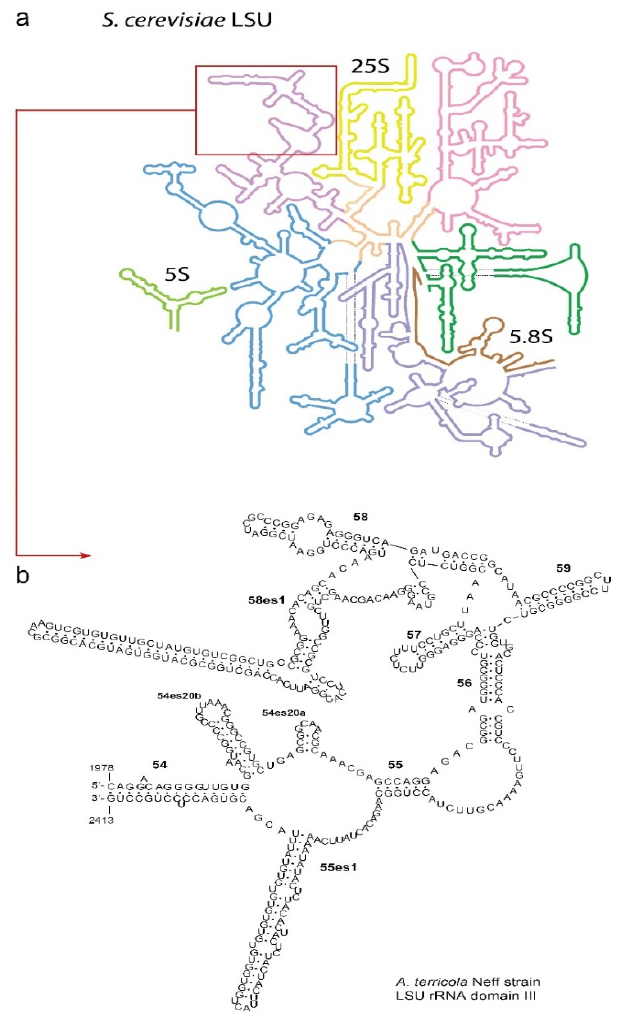
Figure 1. LSU structure: ( a ) an LSU rRNA secondary structure model of the yeast Saccharomyces cerevisiae (http://apollo.chemistry.gatech.edu/RibosomeGallery/, accessed on 24 July 2022). LSU domains I through VI are colour-coded, and 5S and 5.8S are also shown. The red rectangle indicates the region of interest here, in domain III, starting from stem 54; ( b ) the secondary structure of the above region of Acanthamoeba terricola , determined with Mfold. The AU-rich expansion segment 55es1 between 55 and 54 is the hidden break